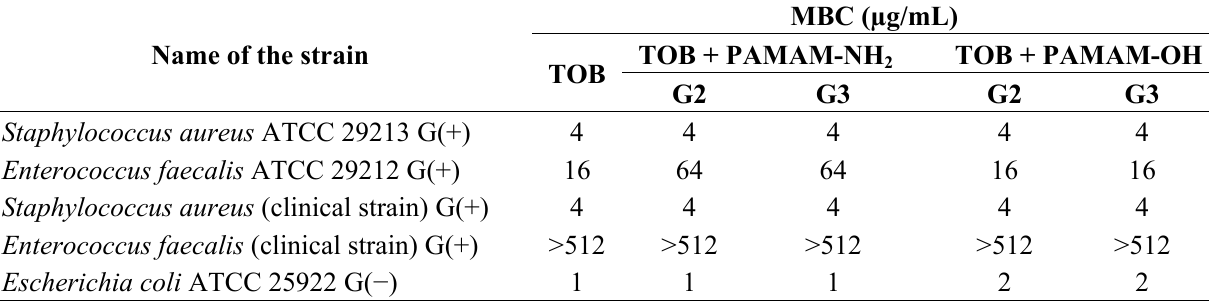
Table 4. Minimum Bactericidal Concentration - MBC (in µg/mL) of tobramycin (TOB) in the presence of PAMAM-NH and PAMAM-OH dendrimers generation 2 (G2) and 2 generation 3